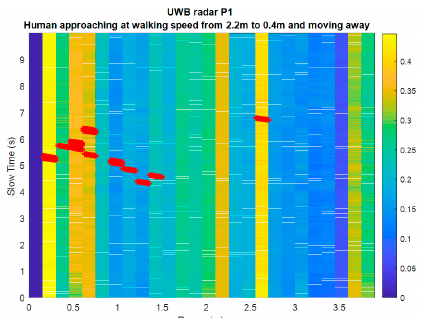
Figure 13. Example of performance verification with a human walking towards the radar.